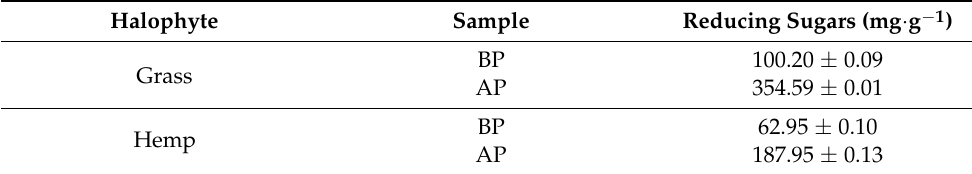
Table 1. Content of reducing sugars before (BP) and after (AP) sodium hydroxide treatment.